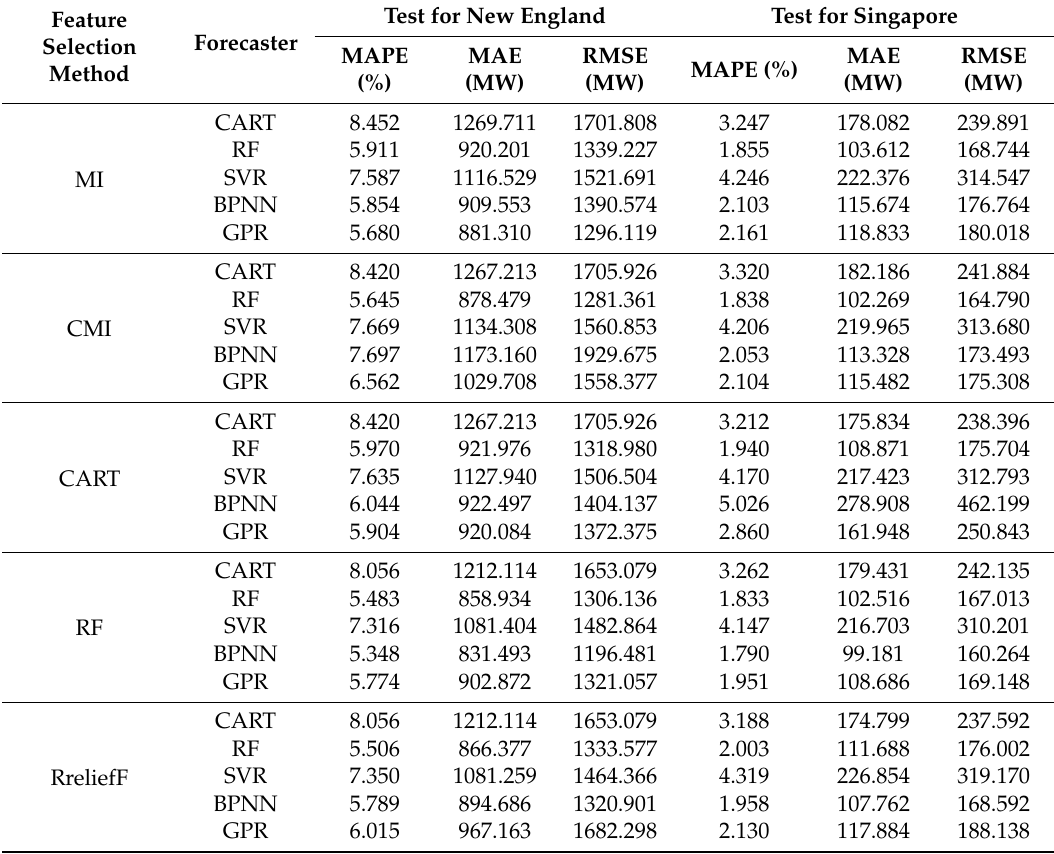
Table 15. Error of load forecasting of different methods with traditional forecasting approach for the whole test